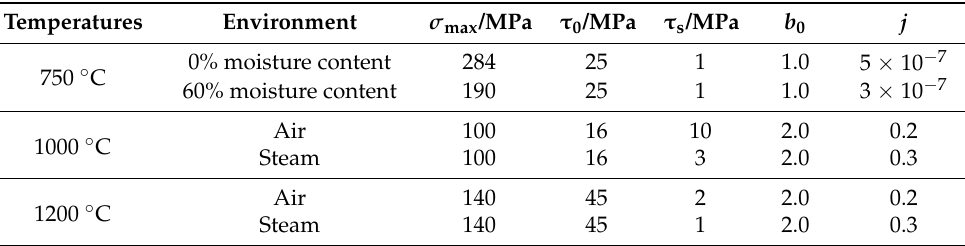
Table 1. The parameters of the interface shear stress degradation model for 2D SiC/SiC composite under different peak stresses, loading frequencies and test